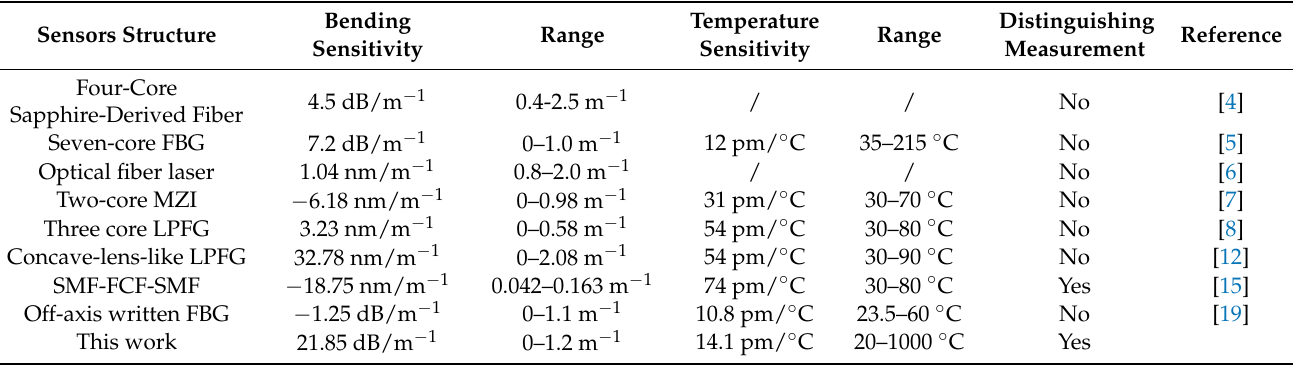
Table 3. Comparison of sensing characteristics of different types of